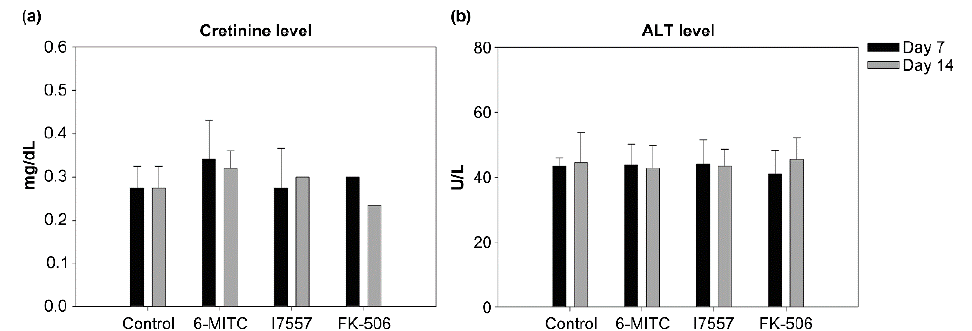
Figure 9. Plasma creatinine ( a ) and alanine aminotransferase (ALT) ( b ) levels of 6-MITC and I7557- treated rats compared with that of the controls following skin transplantation. There were no significant differences in either variable between these groups ( n = 5 in each group).